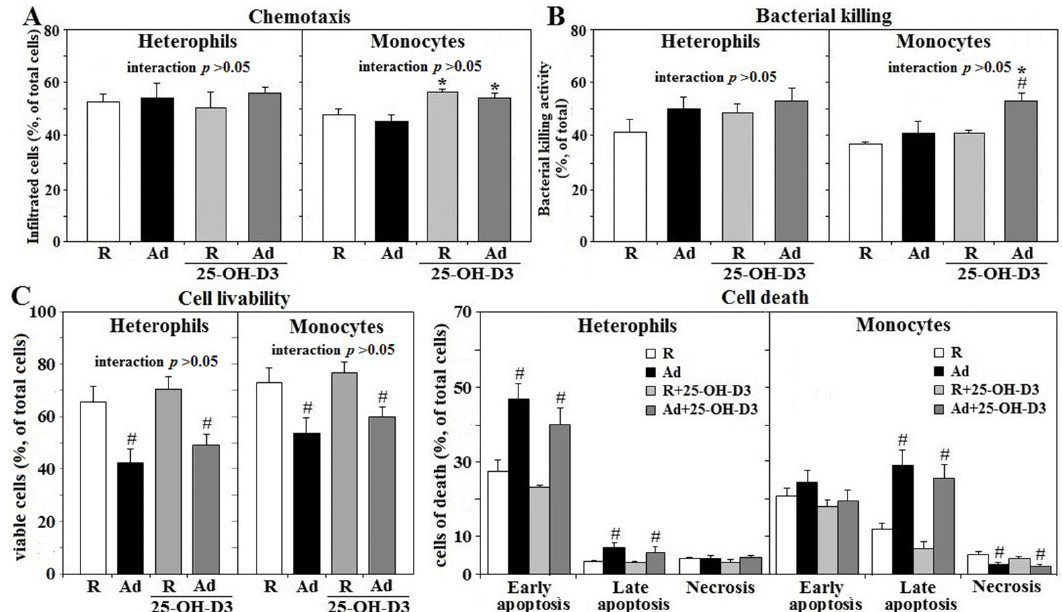
Figure 3. Effects of dietary supplementation of 25-OH-D 3 on chemotaxis, bacterial killing and cell livability of leukocytes in broiler breeder hens under restricted (R) or ad libitum (Ad) feed intake. Freshly prepared cells (2 × 10 5 ) from hens at age of 66 weeks were used for chemotaxis analysis through trans-well method ( A ), incubated with Salmonella Typhimurium (ST) at a 1:2 ratio for 45 min for bacterial killing analysis ( B ), or suspended in RPMI for cell livability analysis ( C ) ( n = 6). Cell viability was defined as the percentage of total cells present that were viable in a cell death analysis with FITC-Annexin-V/propidium iodide (PI) staining and cytometry sorting. Results of bacterial killing were expressed as ratios relative to R-hens. *; significant difference by 25-OH-D 3 , p < 0.05, #; significant difference by Ad-feed intake. 25-OH-D 3 ; 25-hydroxycholecalciferol.